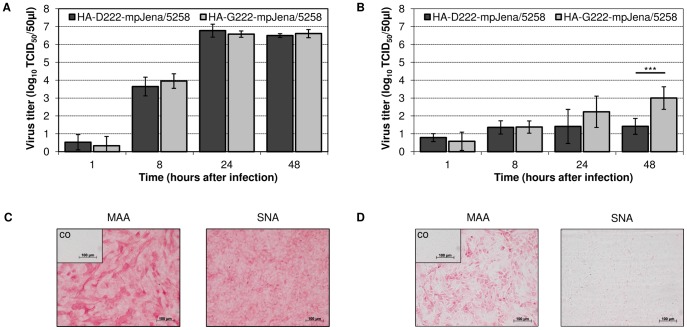
Replication of HA-D222-mpJena/5258 and HA-G222-mpJena/5258 and receptor distribution on MDCK and MDBK cells.(A) MDCK and (B) MDBK cells were infected with HA-D222-mpJena/5258 or HA-G222-mpJena/5258, respectively, at an MOI of 0.1 TCID50/cell. At the indicated time points supernatants were collected and virus titer was determined on MDCK cells. Mean values and standard deviations were calculated from 2 individual tests, each with 3 parallels. (C and D) Lectins MAA and SNA were used to show the distribution of influenza virus receptors SAα2-3Gal and SAα2-6Gal, respectively, in (C) MDCK and (D) MDBK cells. A lectin-free cell control (co) is included for both cell types. *** p<0.001.